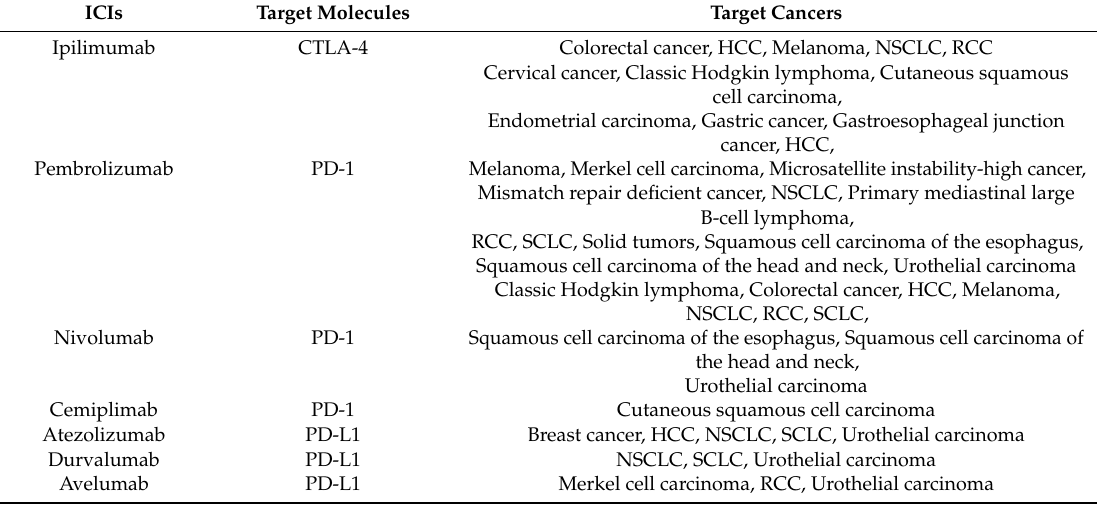
Table 1. The Food and Drug Administration (FDA) -approved target cancers of immune checkpoint